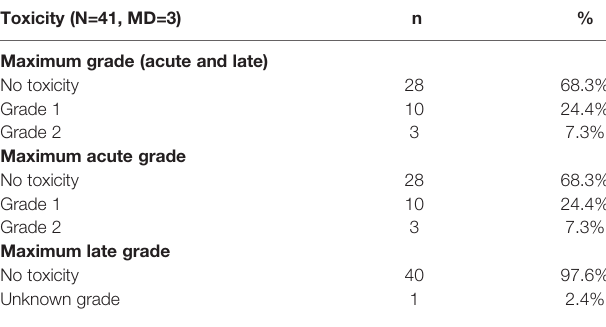
TABLE 3 | Maximum grade of toxicities per